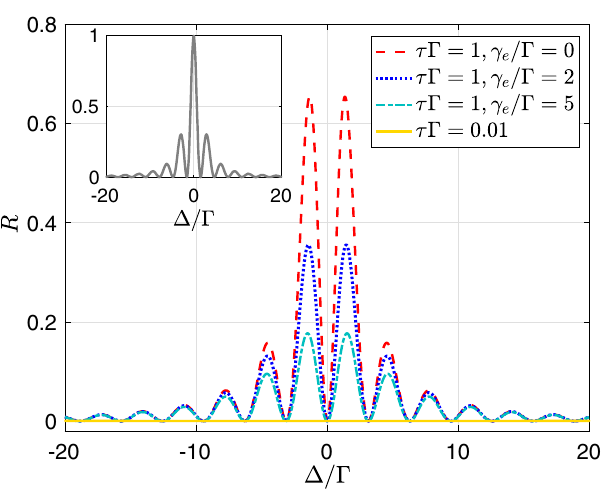
Fig. 4 Re fl ection behaviors in the Markovian and non-Markovian regime. Re fl ection rate R versus the detuning Δ with the coupling phase difference θ = π /2 and the accumulated phase ϕ = π /2. The inset depicts R versus Δ 0 with θ = π /2 and ϕ 0 = π in the case of photon propagation time τ Γ = 1 and atomic dissipation rate γ e / Γ = 0, where Γ is the atomic emission rate into the ffiffiffiffiffiffiffiffiffiffiffiffi p sin ϕ ¼ ± γ 2 Δ 2 = 4 Γ and tan θ = γ e /2 Δ indicating that T 1 → 2 can e þ 4 also exhibit a vanishing minimum for Δ ≠ 0 if we have ffiffiffiffiffiffiffiffiffiffiffiffi p γ 2 Δ 2 ≤ 4 Γ . A similar analysis on Eq. (7a) shows that a perfect e þ 4 destructive interference leading to t 0 ¼ 0 will occur in the case of ffiffiffiffiffiffiffiffiffiffiffiffiffiffiffiffiffiffi q γ 2 Δ due to a reversed = 4 Γ and tan θ = − γ þ 4 Δ 2 sin ϕ ¼ ± e /2 e phase difference ( θ → − θ ) in the direct path. Hence, it is impossible to simultaneously have T 1 → 2 = 0 and T 2 → 1 = 0 for a nonzero external decay ( γ e ≠ 0). The yellow dot-dashed, red dotted, and blue dashed lines in Fig. 3d depict the contrast ratio